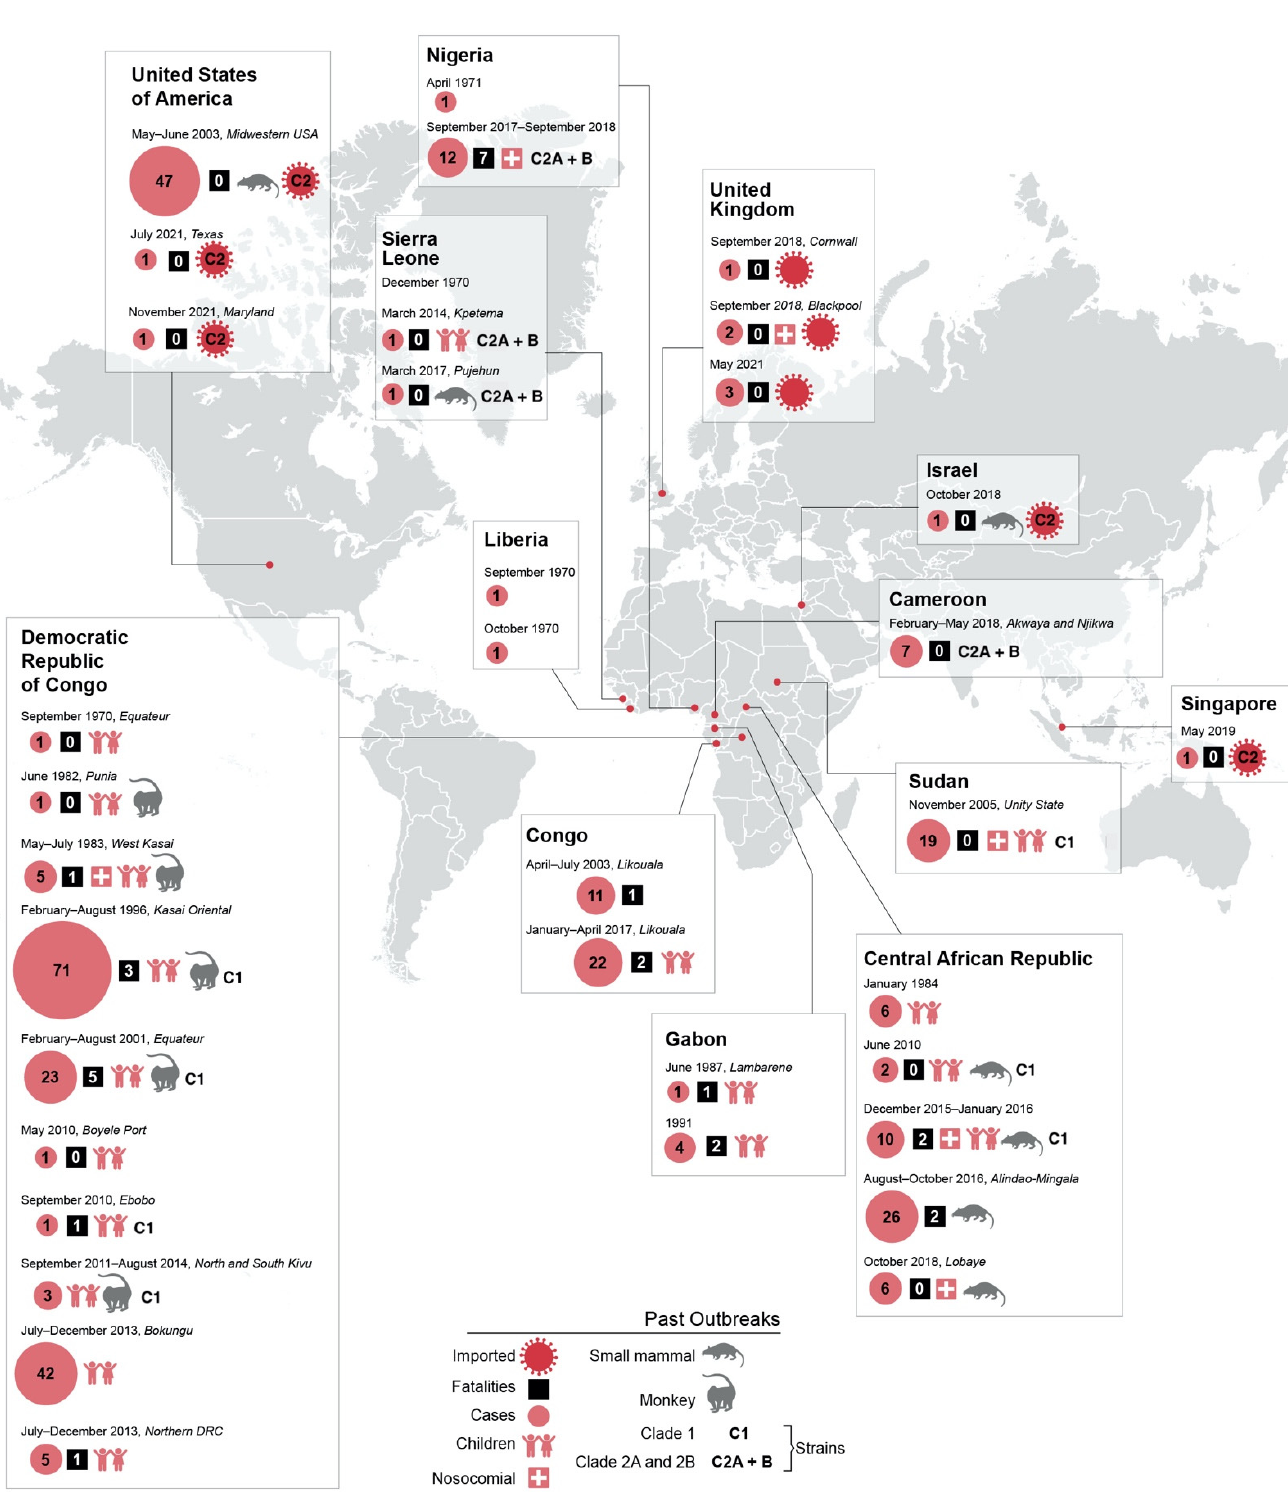
Figure 3. Historical outbreaks of MPX, including imported cases, organized by geographic location. Case numbers, fatalities, MPXV clade, and animal hosts are indicated where known. Outbreaks affecting primarily children and/or associated with nosocomial transmission are notated.